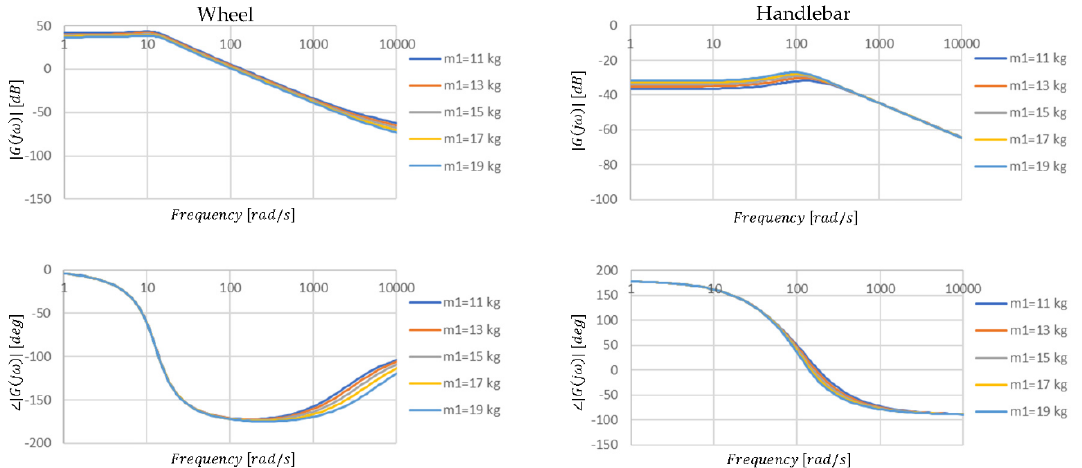
Figure 10. Amplitude and phase characteristics of the transfer function of the handlebar angle position when the value of parameter m 1 is changed. Table 4. The values of the parameters read from the graphs shown in Figure